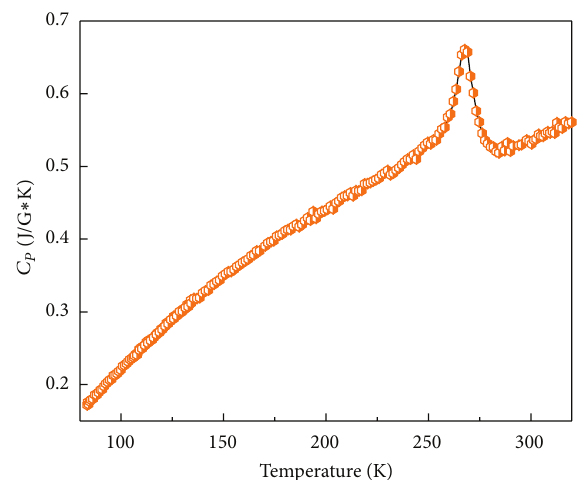
Figure 3: Real part of ac -susceptibility for La 0.7 Ca 0.24 Sr 0.06 MnO 3 single crystal. Figure4:SpecificheatversustemperatureforLa 0.7 Ca 0.24 Sr 0.06 MnO 3 single